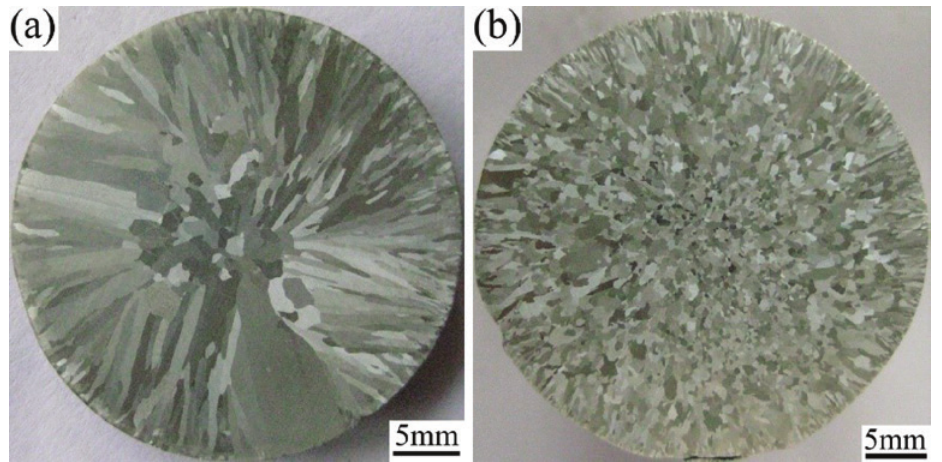
Fig. 5: Macrostructures of tested ingots in the cast condition: (a) without Y, (b) 0.043%Y